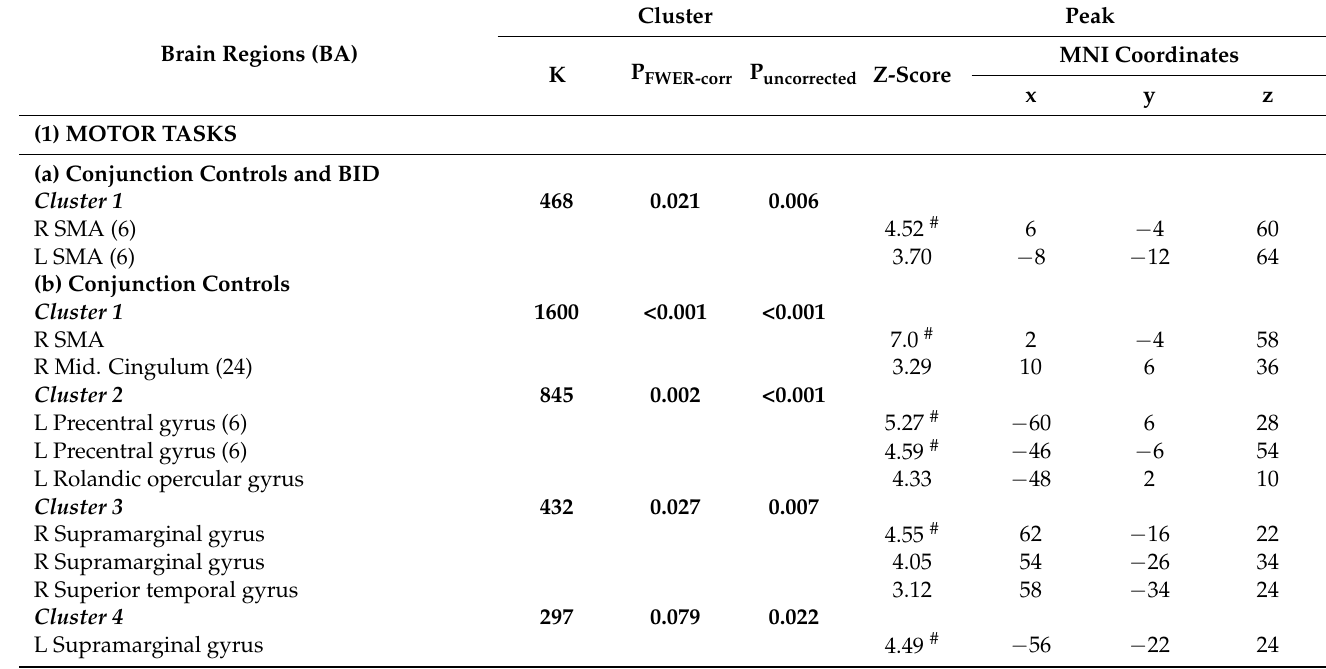
Figure 3. Regional effects in the right paracentral lobule (red area) and in the right superior parietal lobule (green area), regions that in Saetta et al. [28] had altered functional connectivity. The bar-graphs describe the contrast estimates—betas—and their 90% confidence intervals of the fMRI response for each condition in the healthy controls and in the subjects with BID. RH = right hand; LH = left hand; RF = right foot; LF = left foot. Table 4. Conjunction of the effects of the motor and somatosensory tasks. MNI coordinates of the brain regions commonly activated for the four conditions of the motor tasks (1) and the four conditions of the somatosensory tasks (2). Brain regions (R = right hemisphere; L = left hemisphere), cluster size (k = number of voxels), FWER-corrected p -value and uncorrected p -value, peak Z-score and Montreal Neurological Institute (MNI) coordinates are reported. # Statistical threshold p < 0.05 whole-brain FWER-corrected voxelwise. BA = Brodmann areas; corr = corrected. ** labeled as no region in the AAL template and identified by the Neuromorphometrics and the HarvardOxford